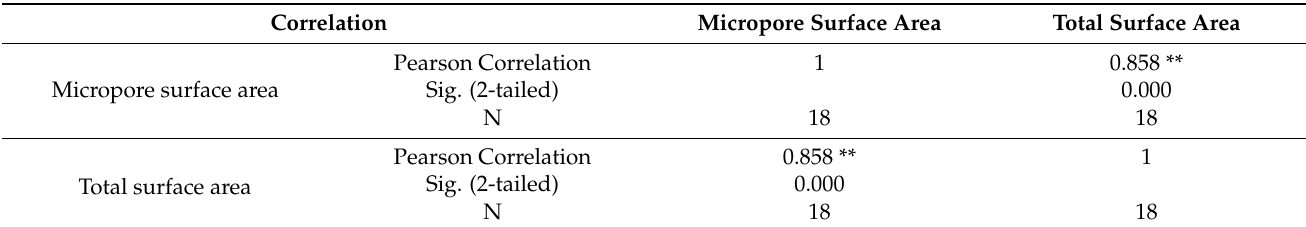
Table 4. Correlation of surface area and micropore of the prepared activated carbons.